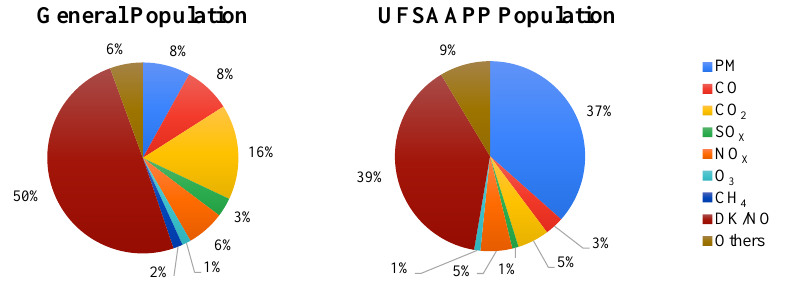
Figure 7. Air pollutants identified by the two studied populations. DK/NO stands for “Do not know/No answer”.